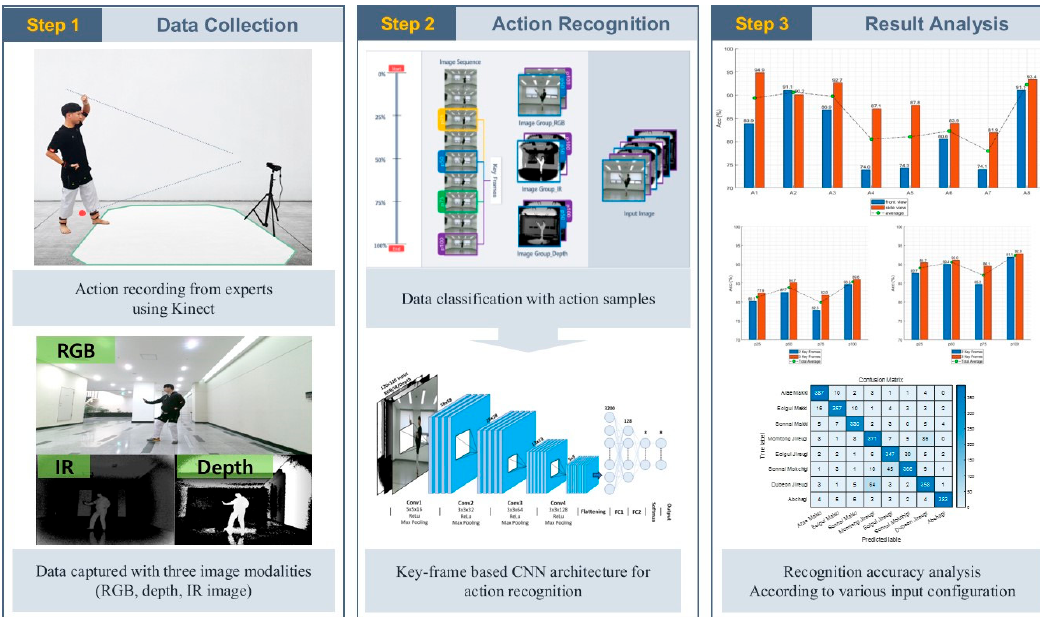
Figure 1. Overall process of the proposed action recognition method.